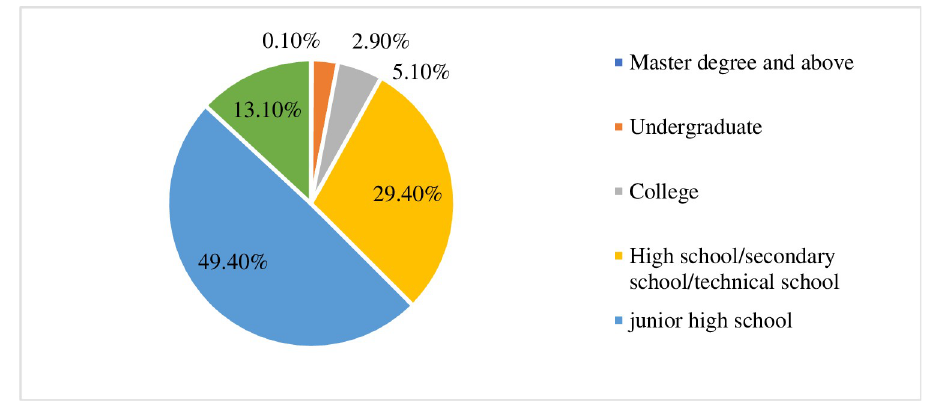
Fig 10. Rural logistics personnel education ratio.